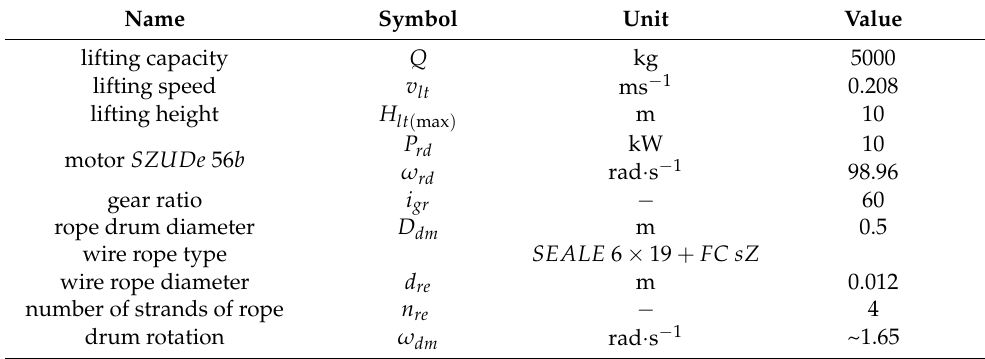
Table 1. Characteristics of the hoisting mechanism.